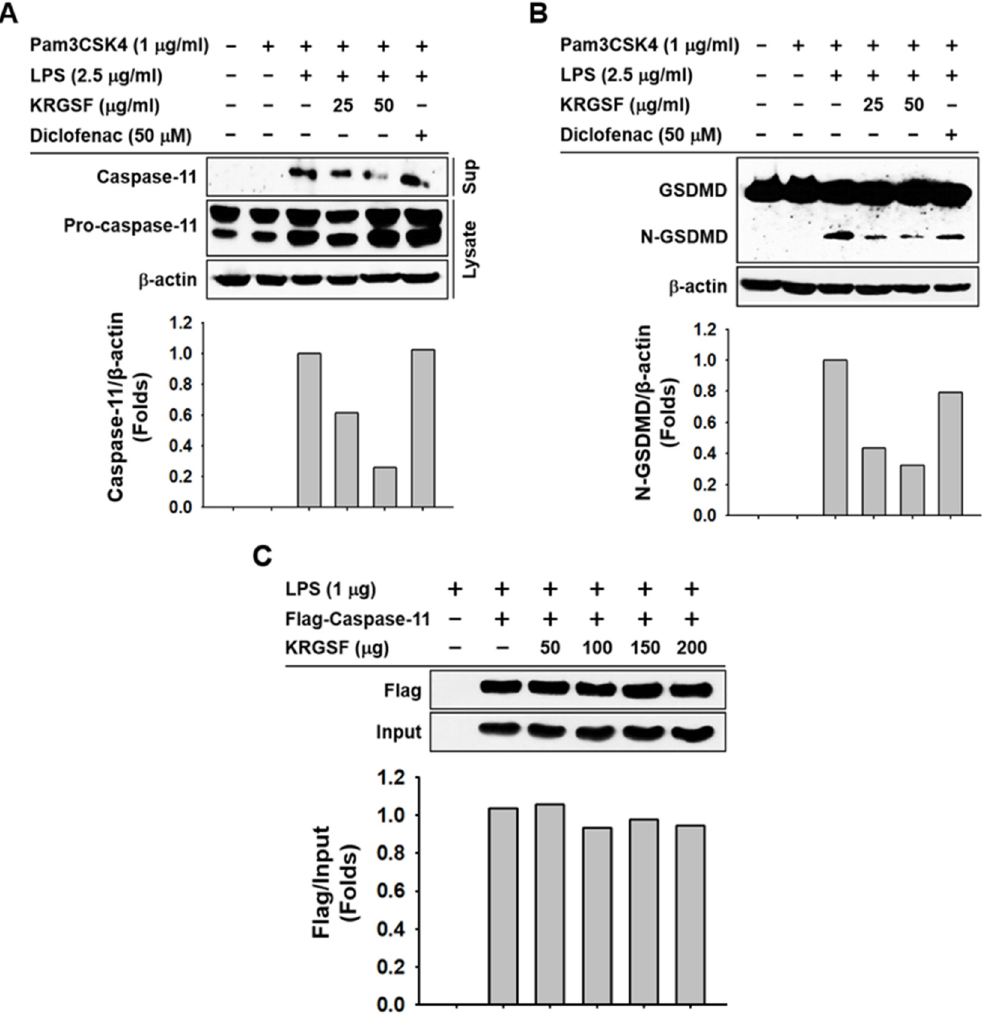
Figure 3. Mechanism of KRGSF-suppressed caspase-11 non-canonical inflammasome activation in J774A.1 cells. J774A.1 cells pretreated with the indicated doses of KRGSF for 1 h were treated with Pam3CSK4 (1 μ g/mL) for 4 h and transfected with LPS (2.5 μ g/mL) for 24 h. ( A ) Pro-caspase-11 and caspase-11 and ( B ) GSDMD and N-GSDMD in the whole-cell lysates and media were examined by immunoblot analysis. ( C ) Whole-cell lysates of the pCMV-flag-caspase-11-transfected HEK293 cells were reacted with biotin-LPS (1 μ g) in the absence or presence of the indicated amounts of KRGSF for 1 h, followed by reaction with streptavidin agarose resins for another 1 h. Caspase-11 levels were determined via western blotting analysis. Band intensity was measured and plotted using the ImageJ